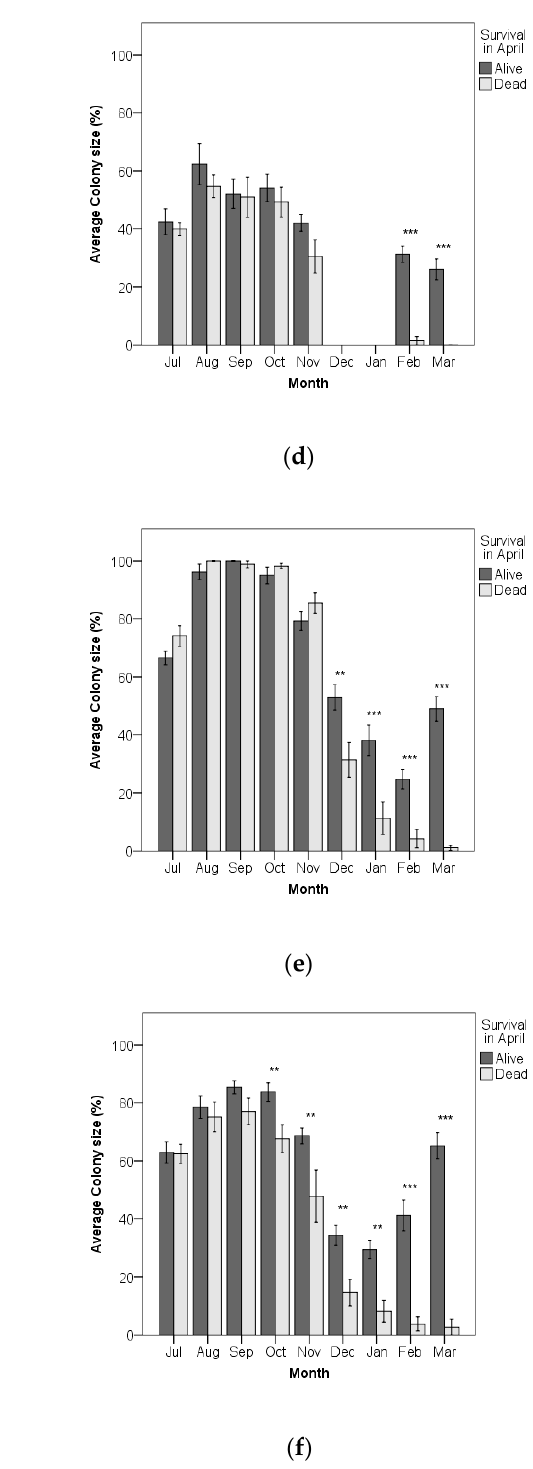
Figure 2. Average colony size (%, [6]) per month for 2012 ( a , d ), 2013 ( b , e ), and 2014 ( c , f ) for colonies with (V − , dark grey bars) or without (V+, light grey bars) acaricide treatment ( a – c ) or colonies alive (dark grey bars) or dead (light grey bars) in March ( e – f ). Asterisks show differences between series (* p < 0.05; ** p < 0.01; *** p < 0.001). Table 2. Results of the linear mixed models for the effects of Varroa destructor (Varroa). Year and month are shown, includ- ing their interaction with the number of mites per gram of bees and the colony size (% top cover). For each factor in the model, the F- and p -values are given. For each model, we give the applied method of estimation (REML = restricted max- imum likelihood), whether we Ln-transformed the dependent variable (Ln), the sample size ( n ), the value of the Aikaike’s information criterion (AIC) and the Repeated Covariance Type.